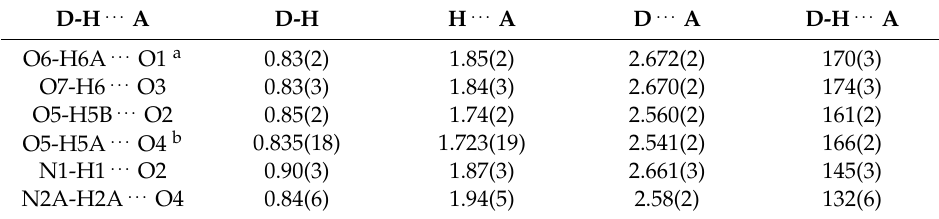
Figure 1. The crystal structure of 2. Hydrogen atoms are omitted for clarity. Displacement ellipsoids are drawn at the 50% probability level. Only the asymmetric unit is labeled, and the major component of disordered atoms are display for clarity. Table 3. Hydrogen bond geometry in 2 (Å,°).